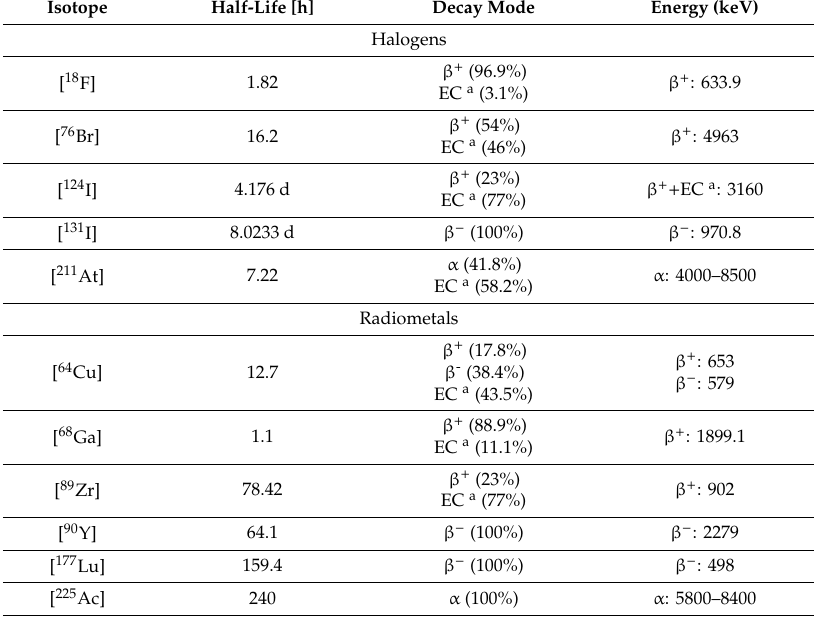
Table 1. Selected physical parameters of the discussed isotopes for positron emission tomography (PET) imaging and therapy (available from The Lund / LBNL Nuclear Data Search: http: // nucleardata.nuclear. lu.se / toi / ; Laboratoire National Henri Becquerel: http: // www.lnhb.fr / nuclear-data / nuclear-data-table /